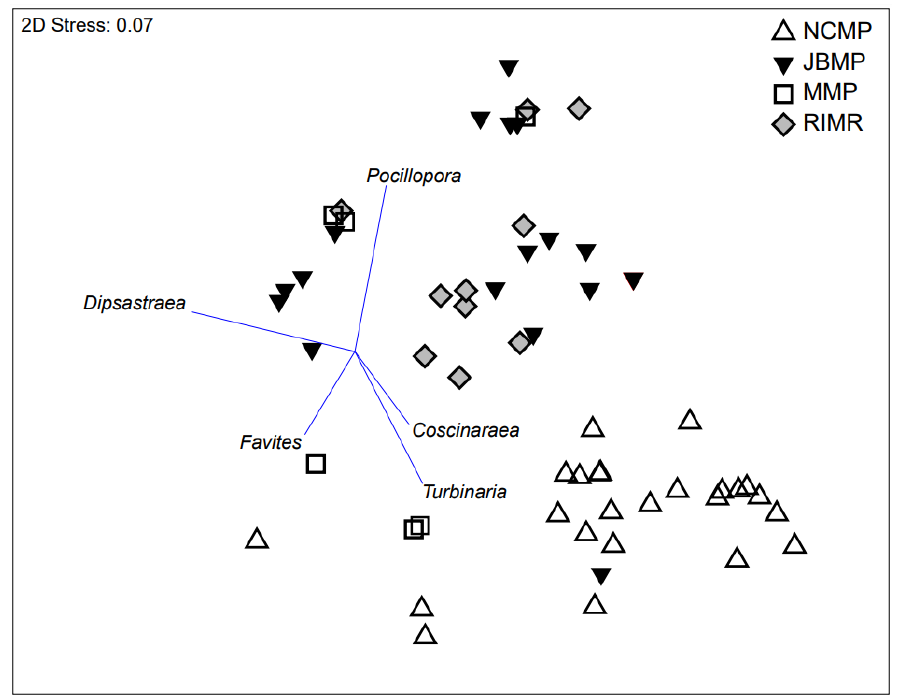
Figure 6. Non-metric multi-dimensional scaling ordination plot based on Bray–Curtis similarity